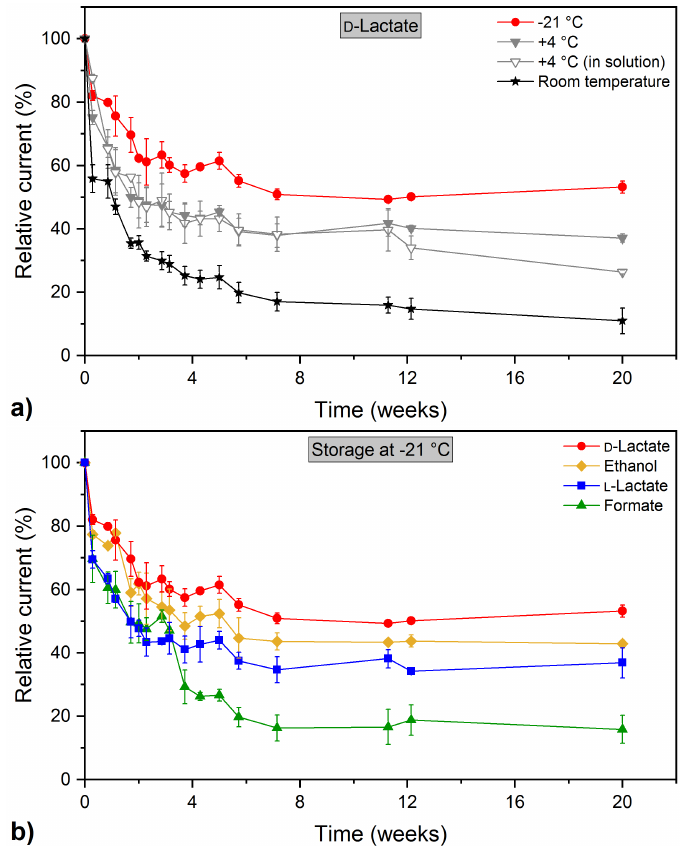
Figure 4. ( a ) Relative current signal as a function of storage time of the D -lactate-sensing electrode in the presence of 1 mmol L − 1 D -lactate in different storage conditions ( − 21 ◦ C, +4 ◦ C, +4 ◦ C in buffer solution and room temperature, respectively); ( b ) Storage stability of the multi-analyte biosensor stored in a freezer at − 21 ◦ C for a period of 20 weeks ( n = 3 sensors) .